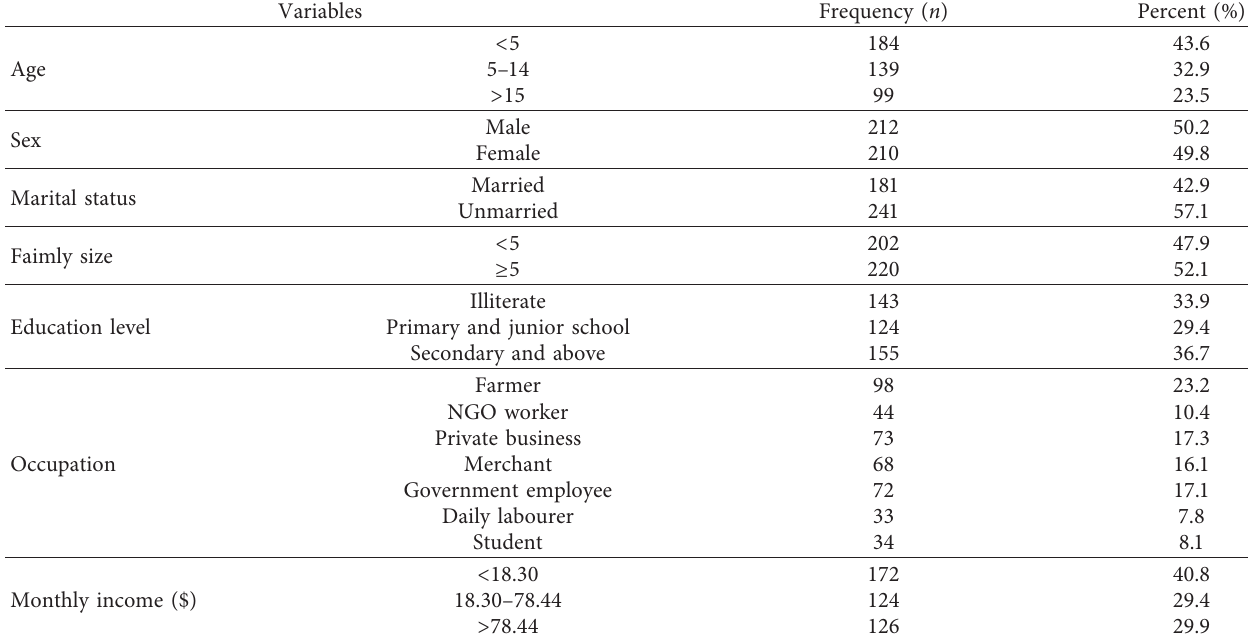
Table 1: Sociodemographic characteristics of the respondents in Shewa Robit, Ethiopia ( n � 422). Variables